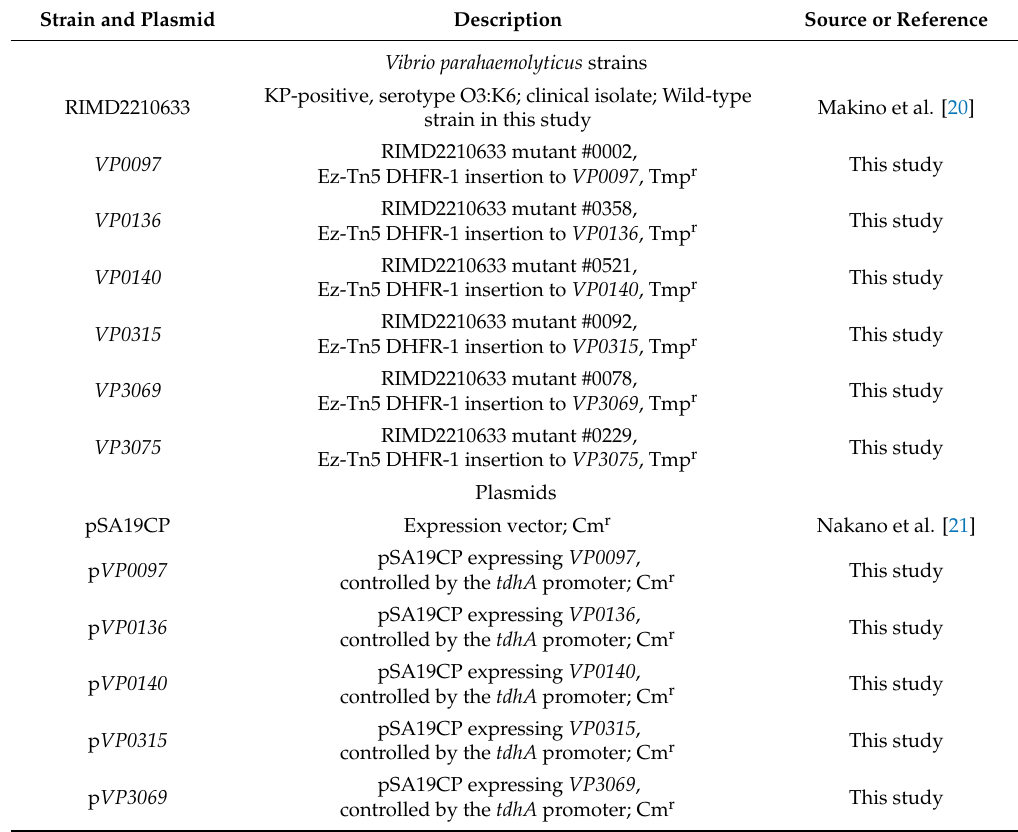
Table 1. Bacterial strains and plasmids used in this